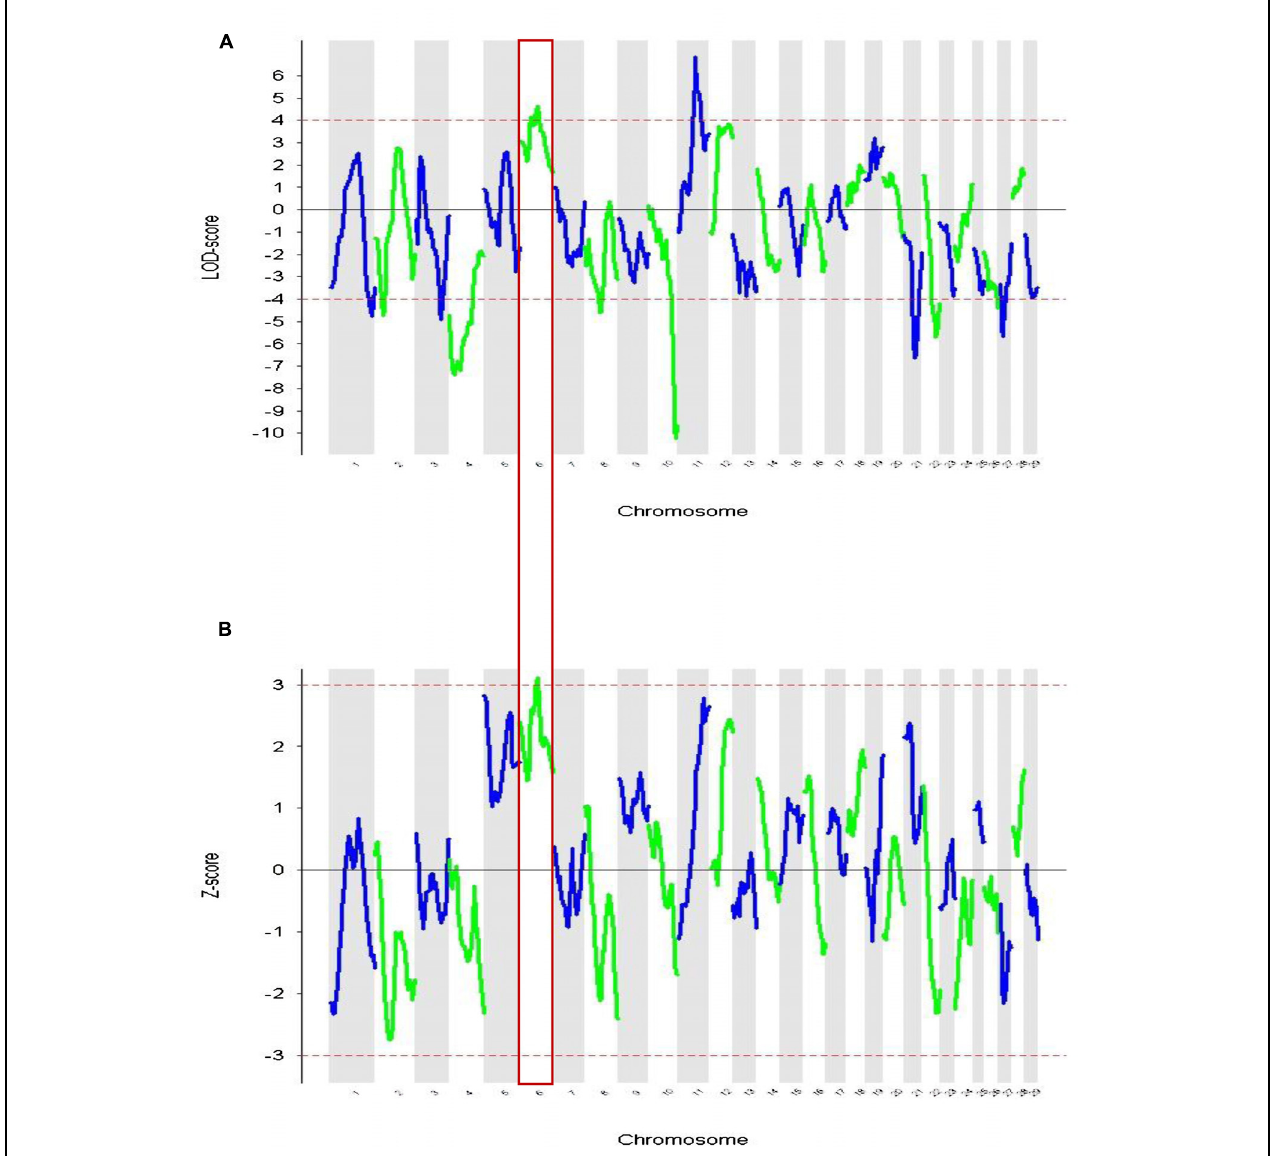
FIGURE 4 | Admixture mapping of cases vs. controls for each chromosome. The association of comparative intra dermal tuberculin test (CIDT) positivity with ancestral origin is shown. (A) Cases only analysis (LOD) and (B) case-control score ( Z -score). Chromosome 6 is highlighted and has significant values in both analyses.